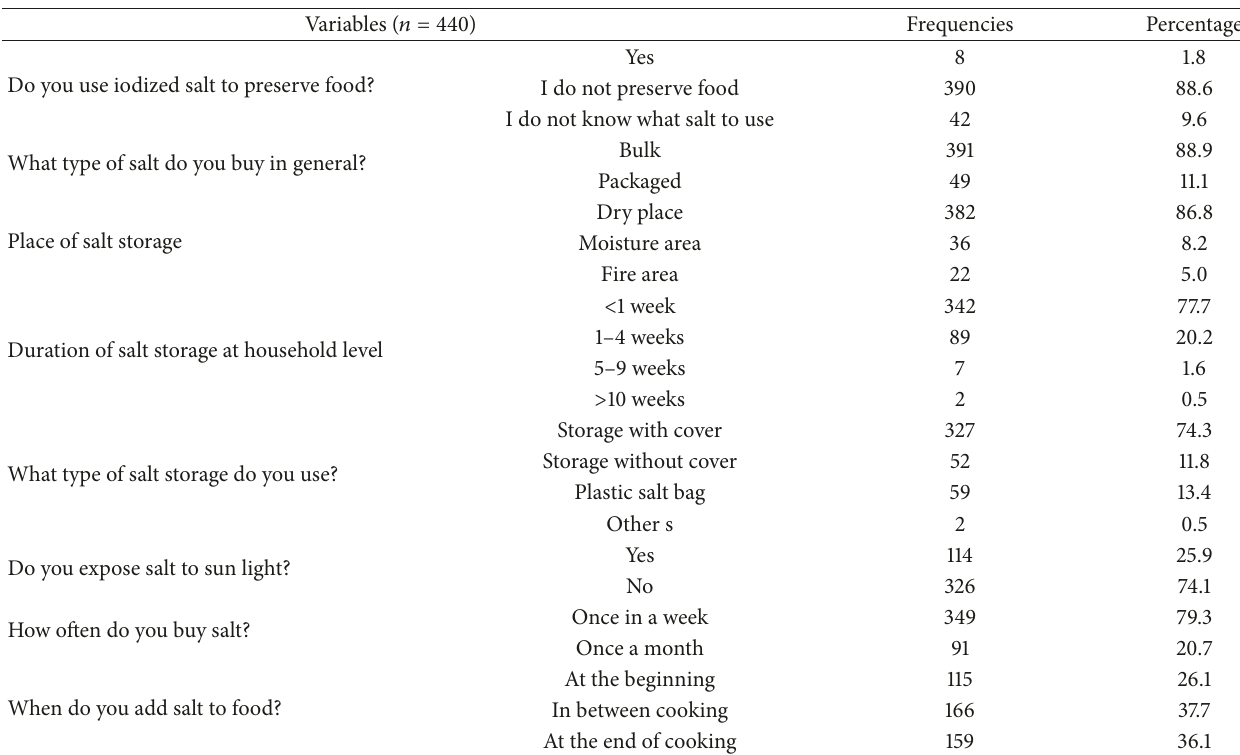
Table 2: Households practices of respondents in salt utilization, Wolaita Sodo town and its peripheries, Southern Ethiopia 2016.